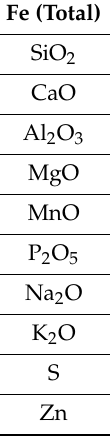
Table 1. Chemical composition of iron ore in wt.% according to X-ray fluorescence (XRF)